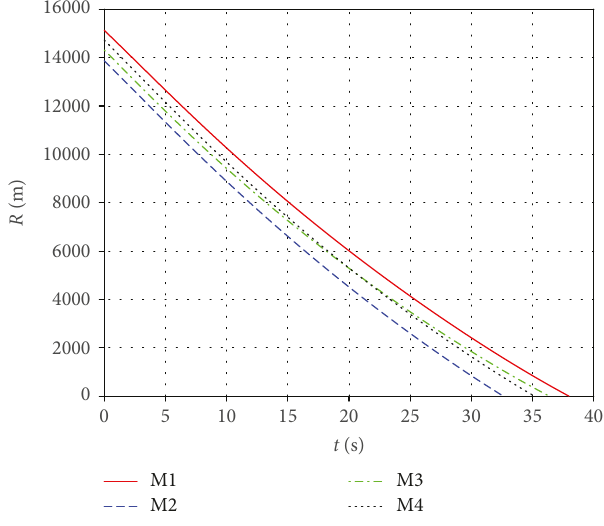
Figure 6: Relative distances between missiles and the target by